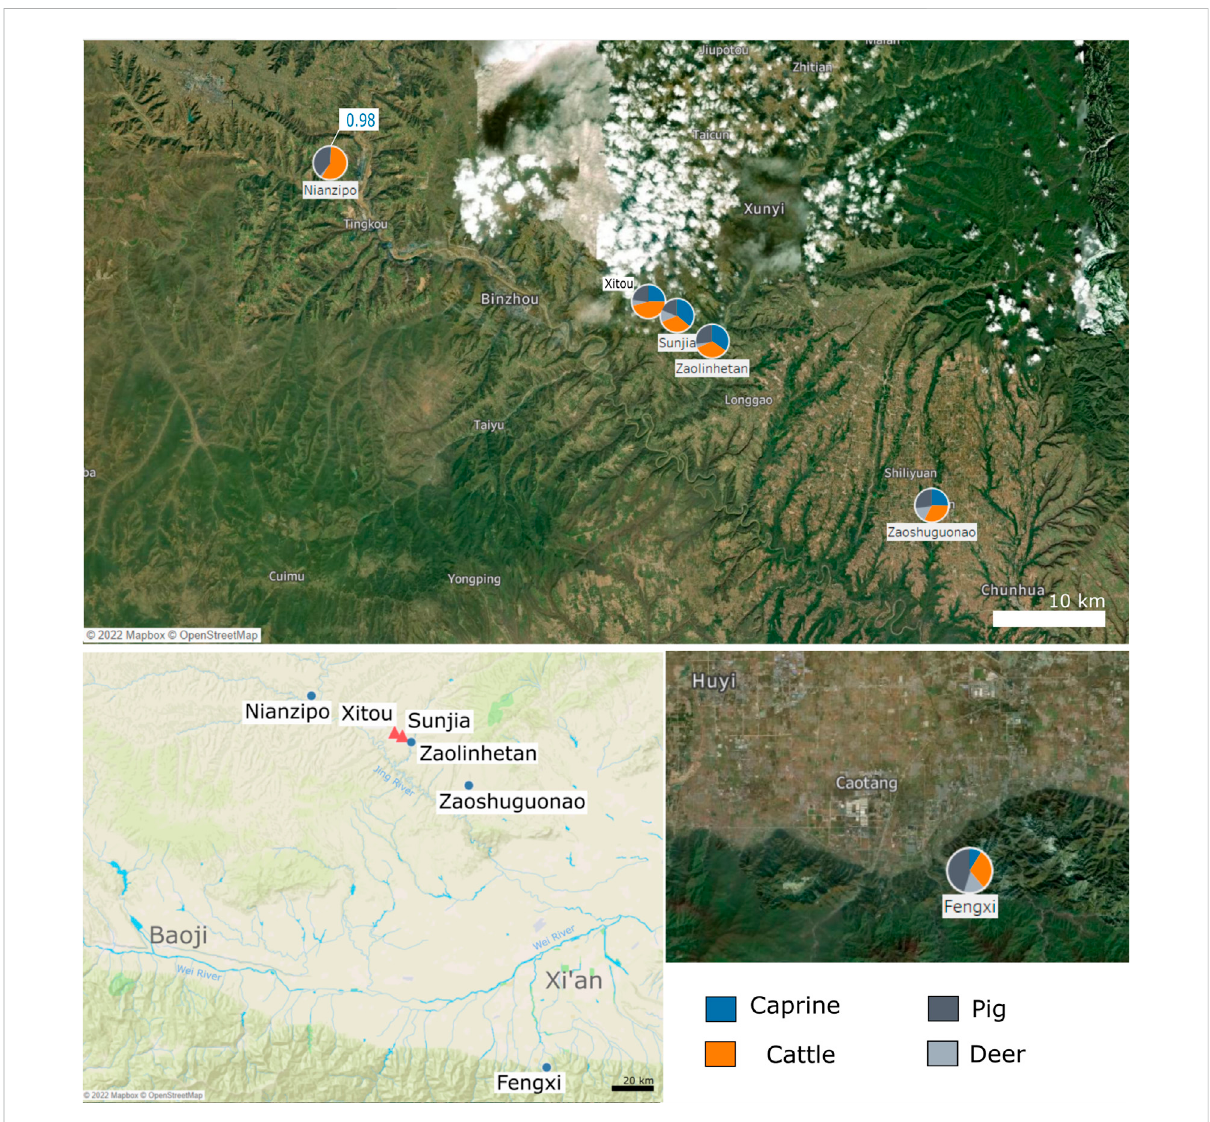
FIGURE 8 Relativetaxonomicfrequencyforthemaindomestictaxa(pigs,caprineandcattle)anddeerby%NISPinthesitesmentionedinthisstudy:SunjiaandXitou (thisstudy),Nianzipo(ZhongguoShehuiKaxueXueyuanKaoguYanjiushuo,2007),Zaolinhetan,Zaoshuguonao(Lietal.,2020).Bottomright:Relativetaxonomic frequencyforthemaindomestictaxa(pigs,caprineandcattle)anddeerby%NISPinFengxi(Yuan,2000).DatafromthesitesofBeicunandLaoniupowerenot complete and could not be plotted with those from the other sites. Bottom left. Location of the mentioned sites (Tableau, F.